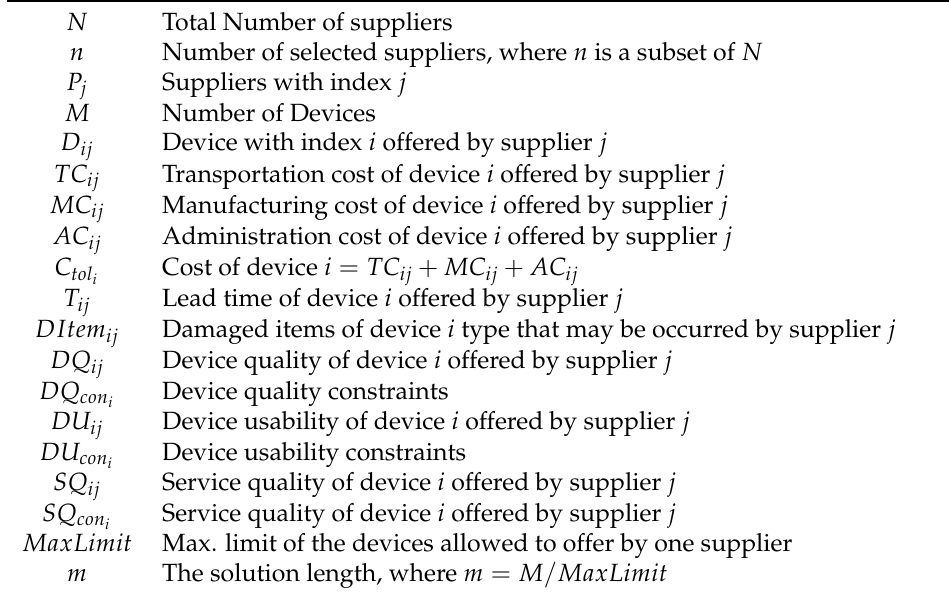
Table 2. Summary of the symbols that are used in the proposed